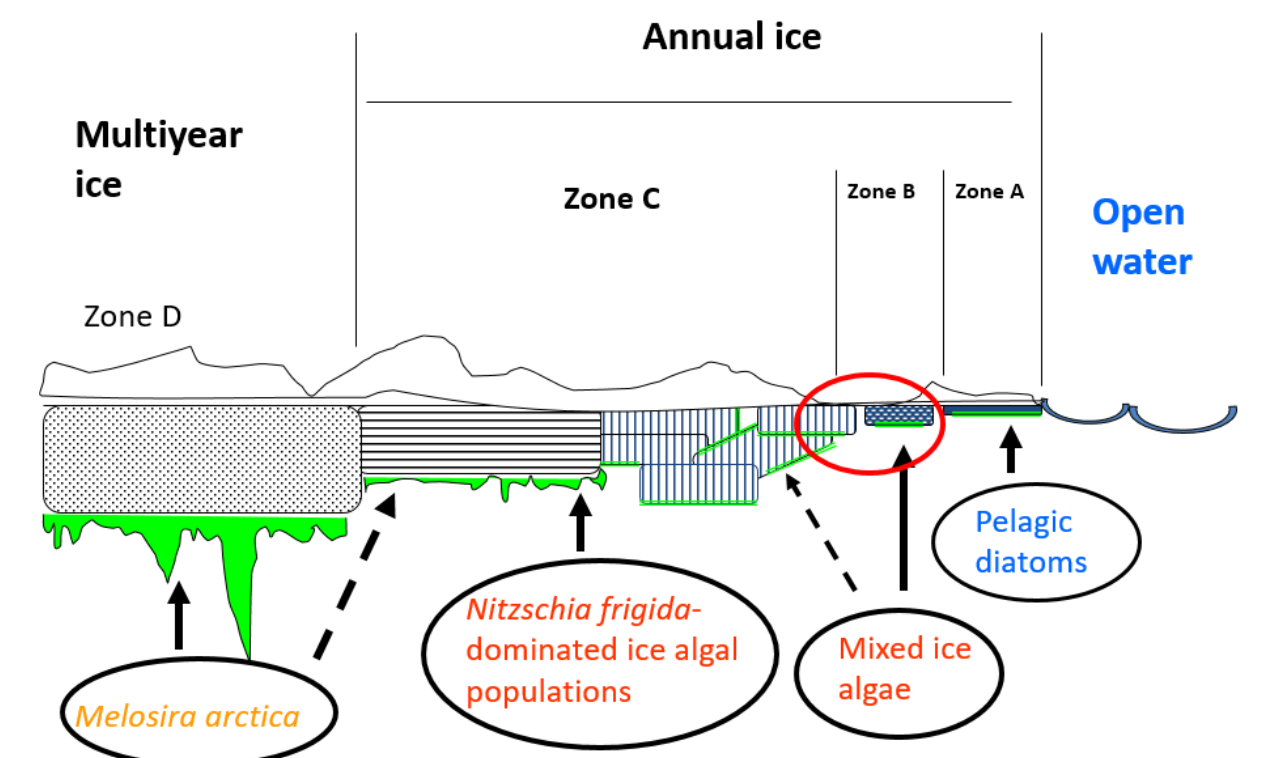
Figure 7. Spatial distribution of ice algal species in the Barents Sea pack ice in relation to increasing ice thickness from open water to multi-year ice. The thin-to-medium thick ice in the outermost zone (zone B: Table 2, Figure 7) is an